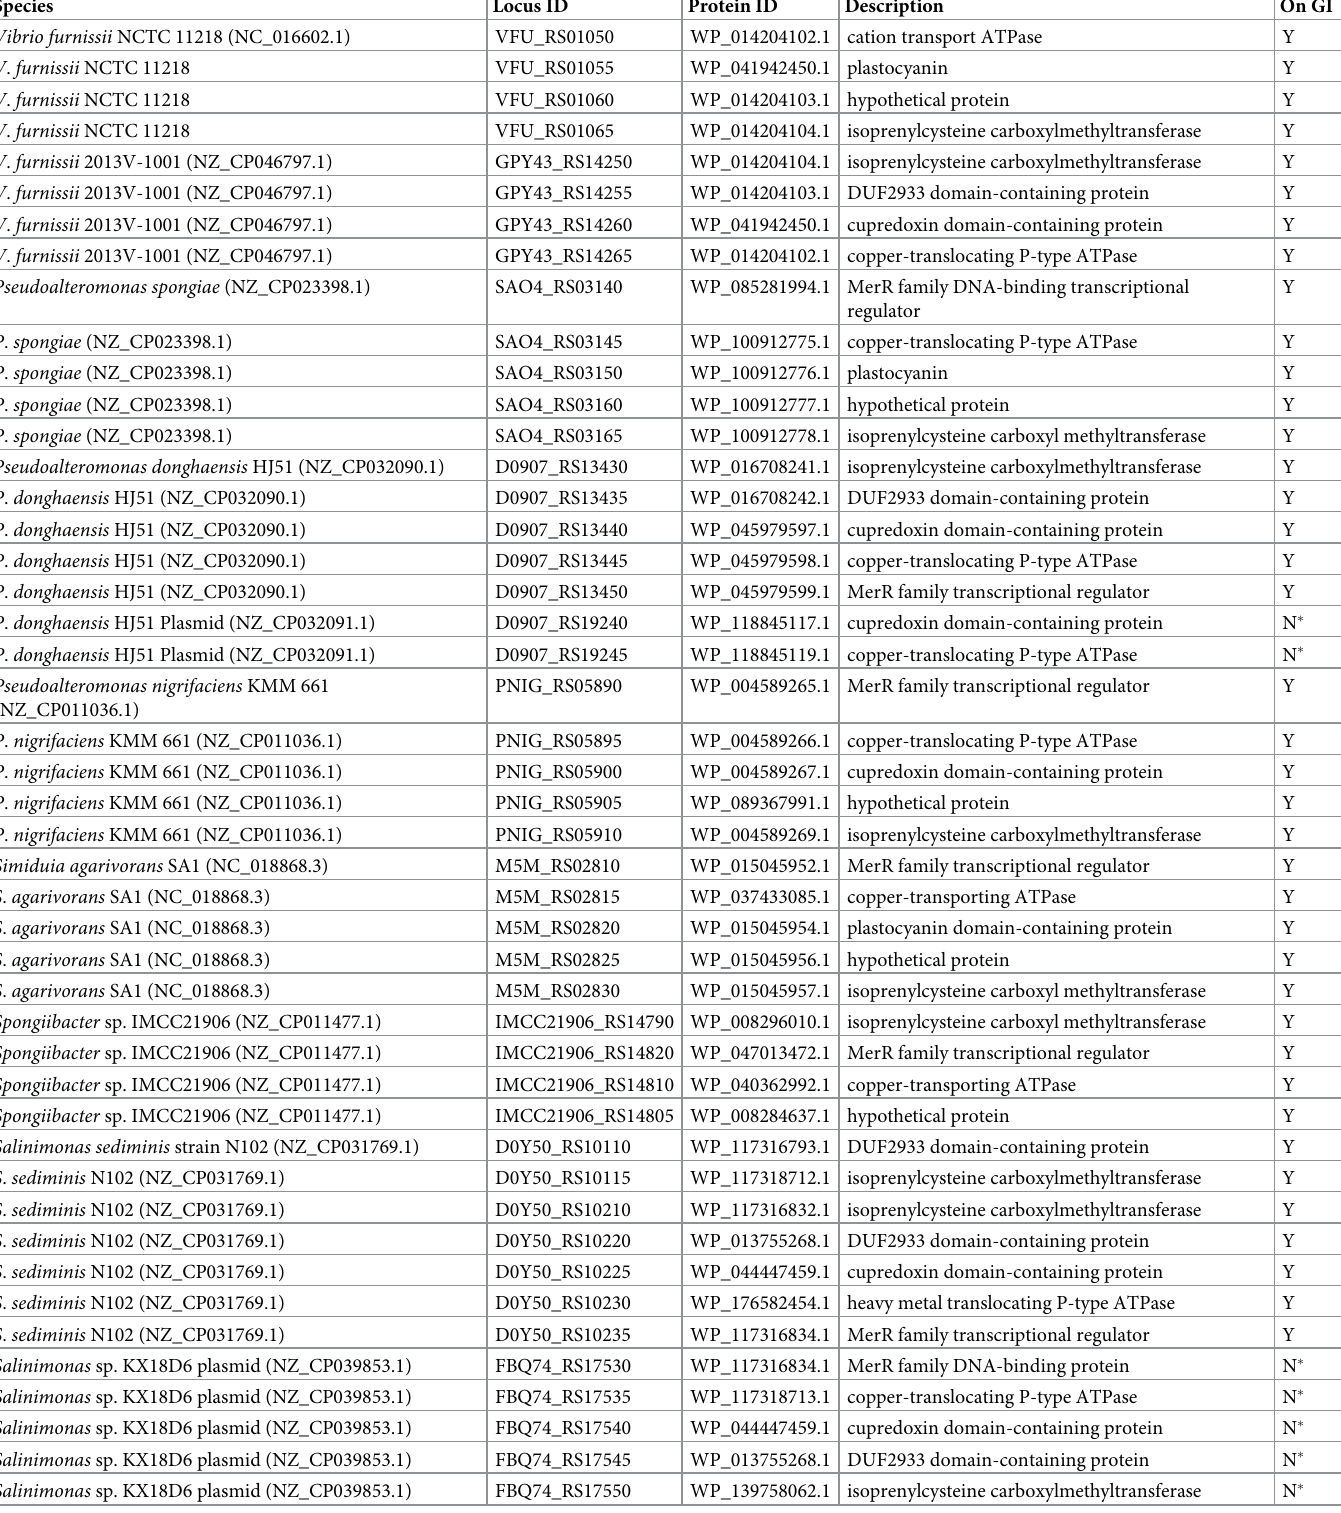
Table 5. copA cluster presence and genome organization across